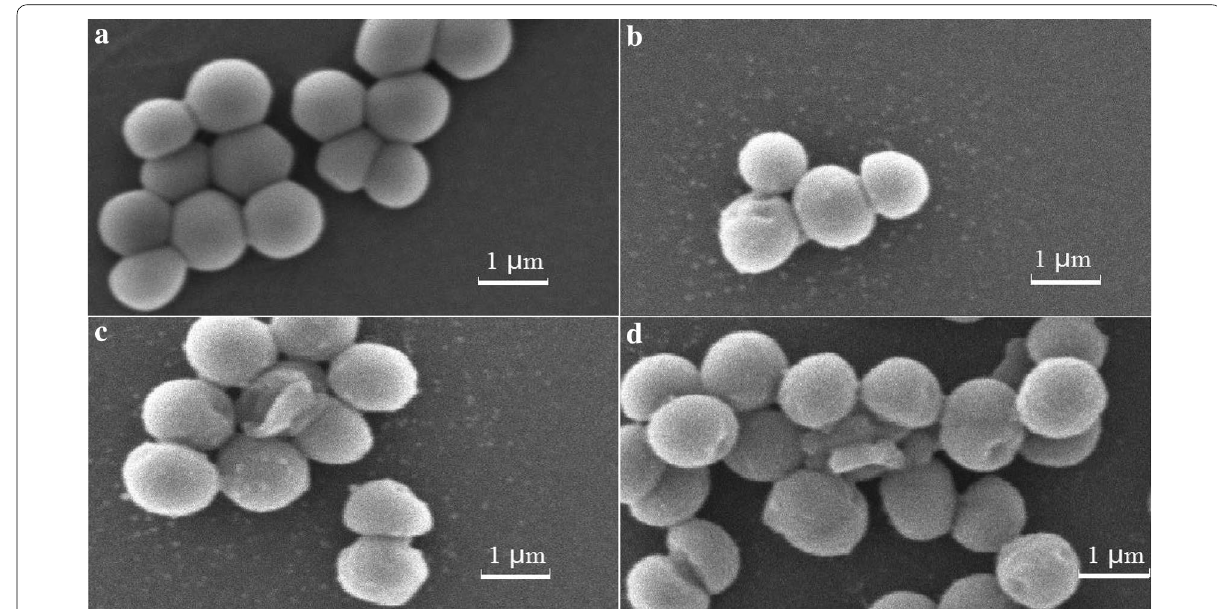
Fig. 2 Effect of ε-PL on the morphology of S. aureus by SEM. a Control, b 250 µg/mL, c 500 µg/mL, and d 750 µg/mL; each group was treated for 2